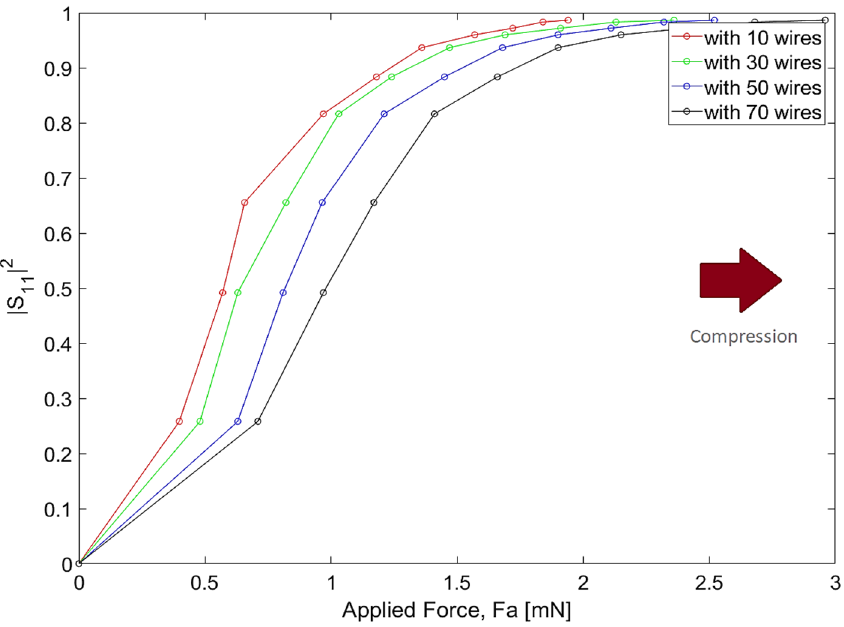
Figure 15. Reflectance as a function of applied force for 10, 30, 50 and 70 wires and a filter assembled with PTFE.